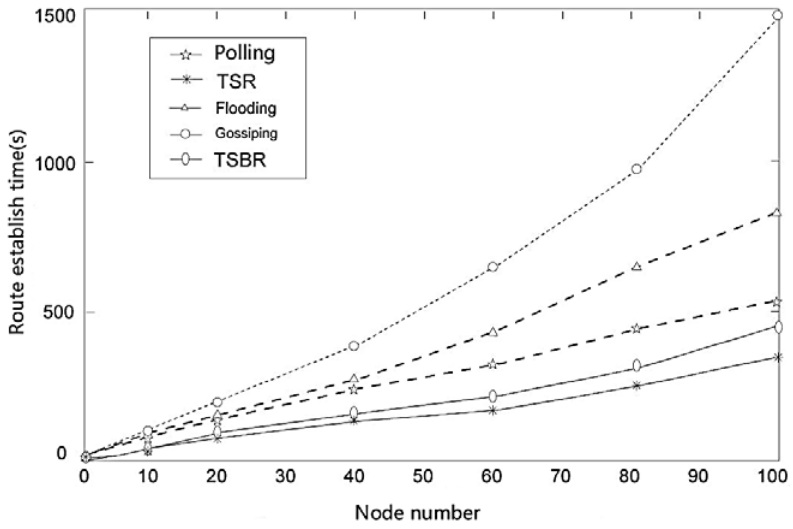
Figure 8. Route establishment time under different node numbers.